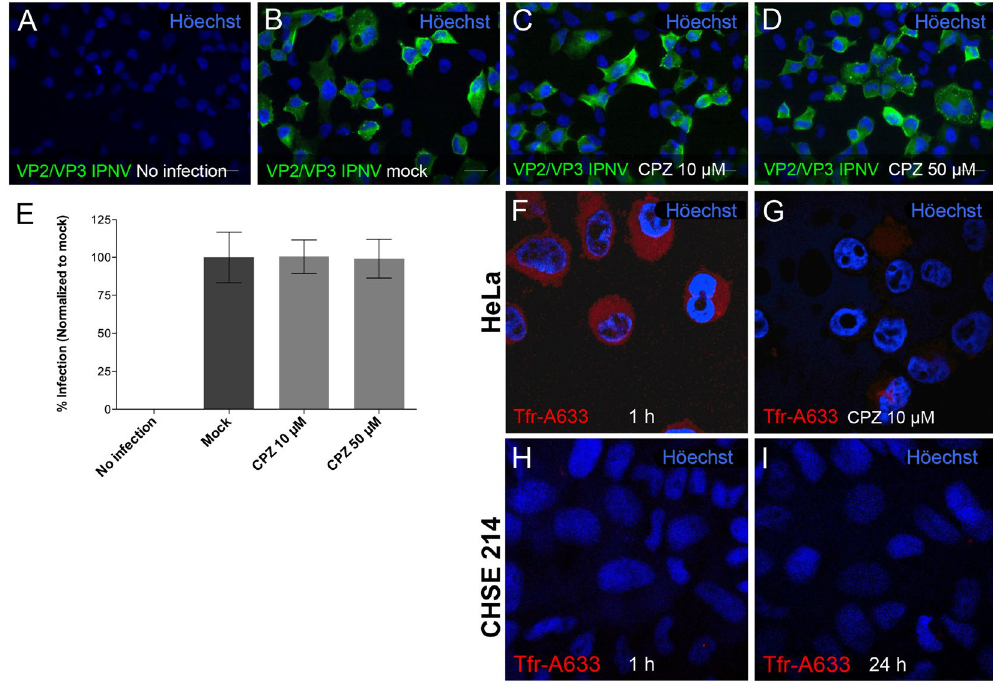
Figure 2. Chlorpromazine does not affect IPNV infection in CHSE-214 cells. CHSE-214 cells were propagated to 70–80% confluence in 24-well plates with round glass coverslips. IPNV was inoculated for 1 h in the presence of 0 ( B ), 10 ( C ) or 50 ( D ) μ M CPZ. After 8 h of incubation at 20 °C, cells were processed by indirect immunofluorescence (IFI) for IPNV VP2/VP3 and images were recorded using a Olympus Spinning Disk IX81 microscope. Representative images are shown (scale bar = 20 µ m). For each condition, 250 cells were counted. Number of VP2/VP3-expressing cells is shown as percentage, normalized to mock cells ( E ). Control HeLa cells were pre-incubated for 1 h with 0 ( F ) or 10 μ M CPZ ( G ), and 5 μ g/ml of Alexa Fluor 633-conjugated transferrin (Trf-A633) was added. After 15 min of incubation cells were processed for confocal fluorescence microscopy. Trf-A633 was added to CHSE-214 and cells were incubated for 1 ( H ) and 24 h ( I ). Representative images are shown (scale bar = 10 μ